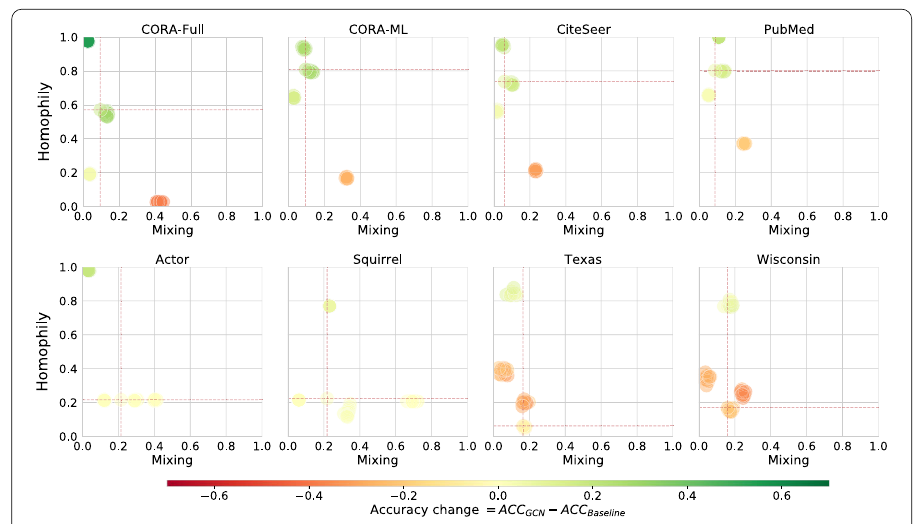
Fig. 9 Homophily and mixing impact on SAGE